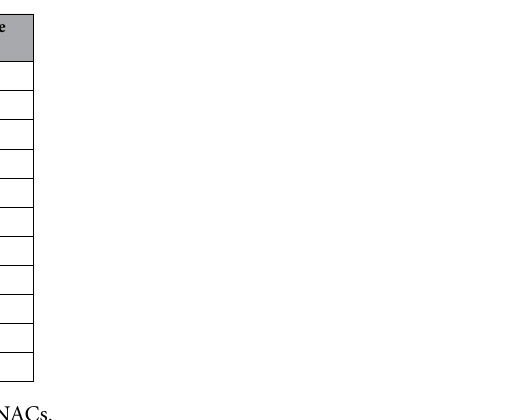
Table 1. Putative membrane-bound switchgrass